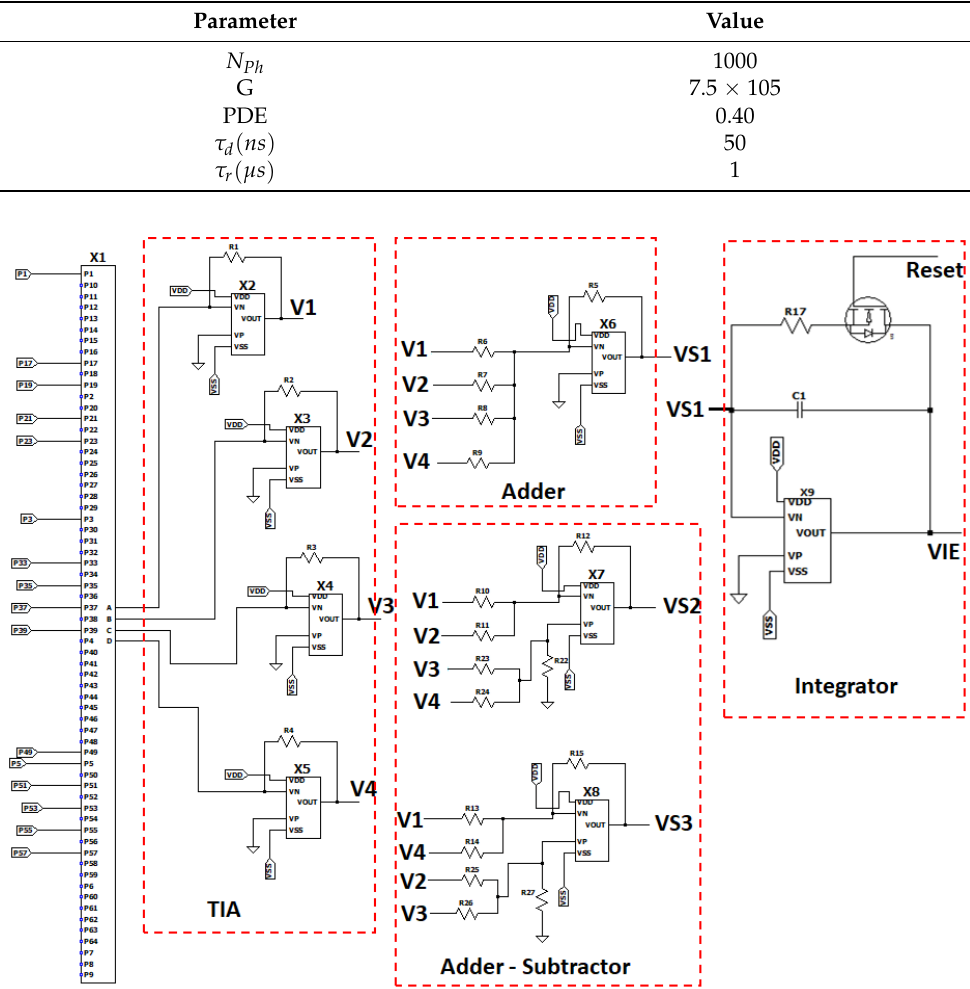
Figure 9. Simulation model of the GaN readout system.